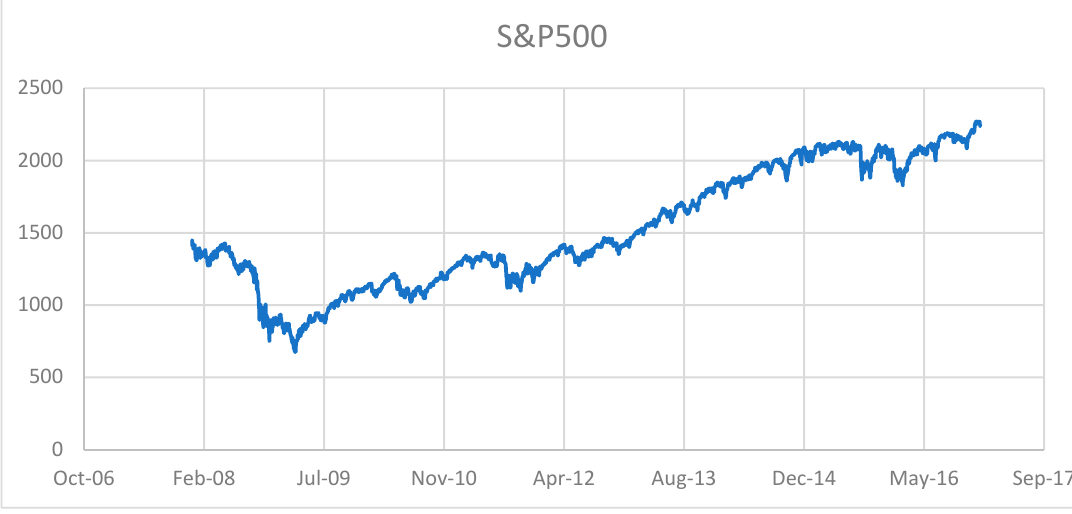
Figure 2. S&P500 INDEX. Source: Standard and Poor’s.